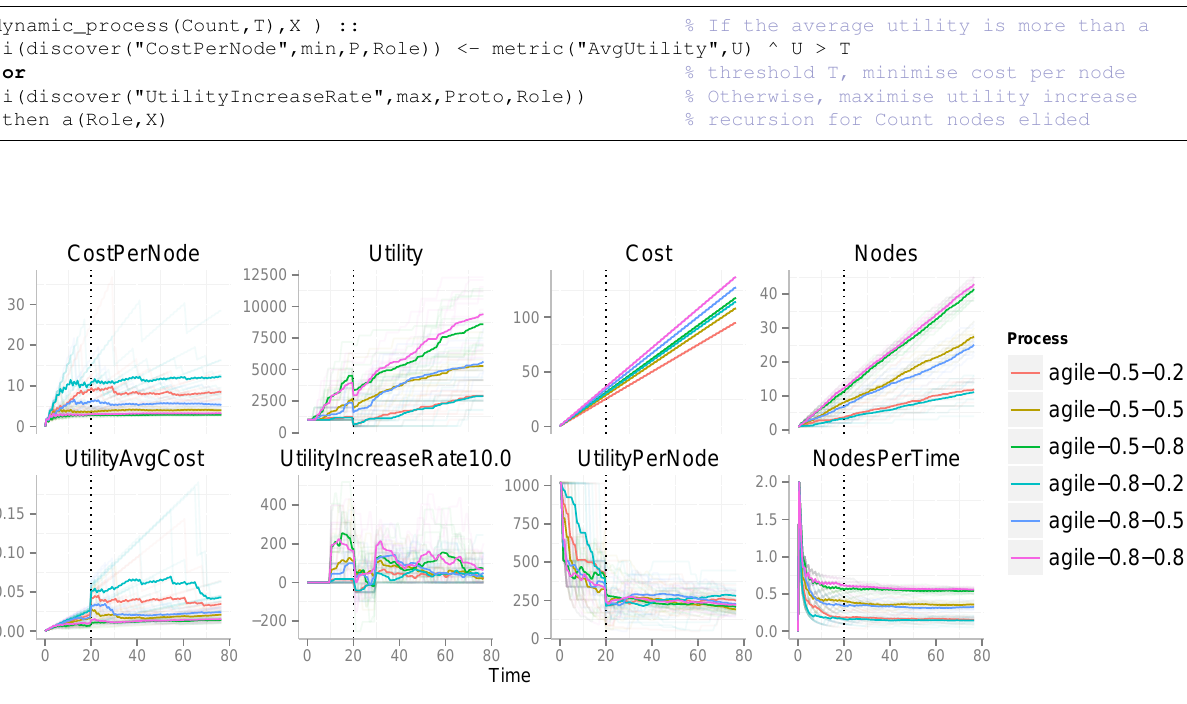
Figure 8. Graph of the performance of the agile protocol on several different metrics over a representative sample of parameter space. Parameters EvalQ and ImplQ are sampled at 0 . 5 , 0 . 8 and 0 . 2 , 0 . 5 , 0 . 8 respectively, giving 6 conditions. The metrics shown are: i) CostPerNode , the average cost for each node implemented; ii-iv) Utility , Cost , and number of Nodes ; v) UtilityAvgCost , the average cost of each unit of utility; vi) UtilityIncreaseRate 10 . 0 , increase rate in utility over a 10 tick window; vii) UtilityPerNode , the total utility divided by the number of implemented nodes; viii) NodesPerTime , the average number of implemented nodes per unit of time. All simulations were carried out on randomly generated trees with branching factor 4 and max depth 3, with a population of